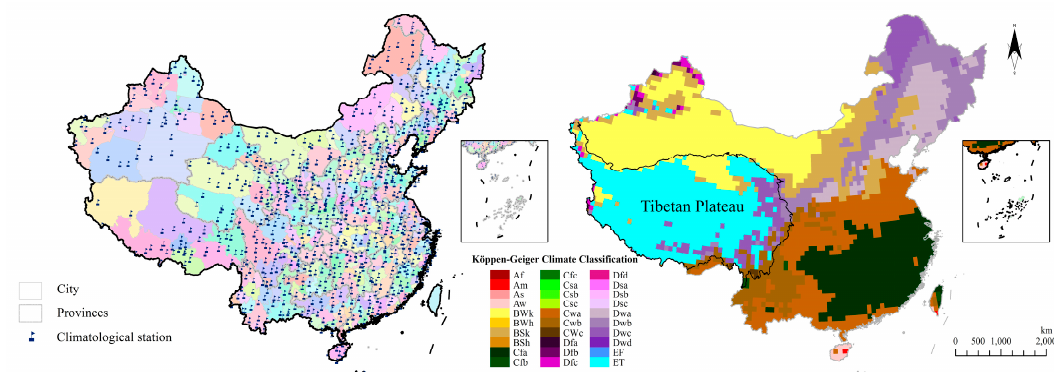
Figure 1. Selected meteorological stations and the climate Köppen of China. (The climate Köppen of China data is downloaded from the World Maps of Köppen-Geiger Climate Classification [12]).